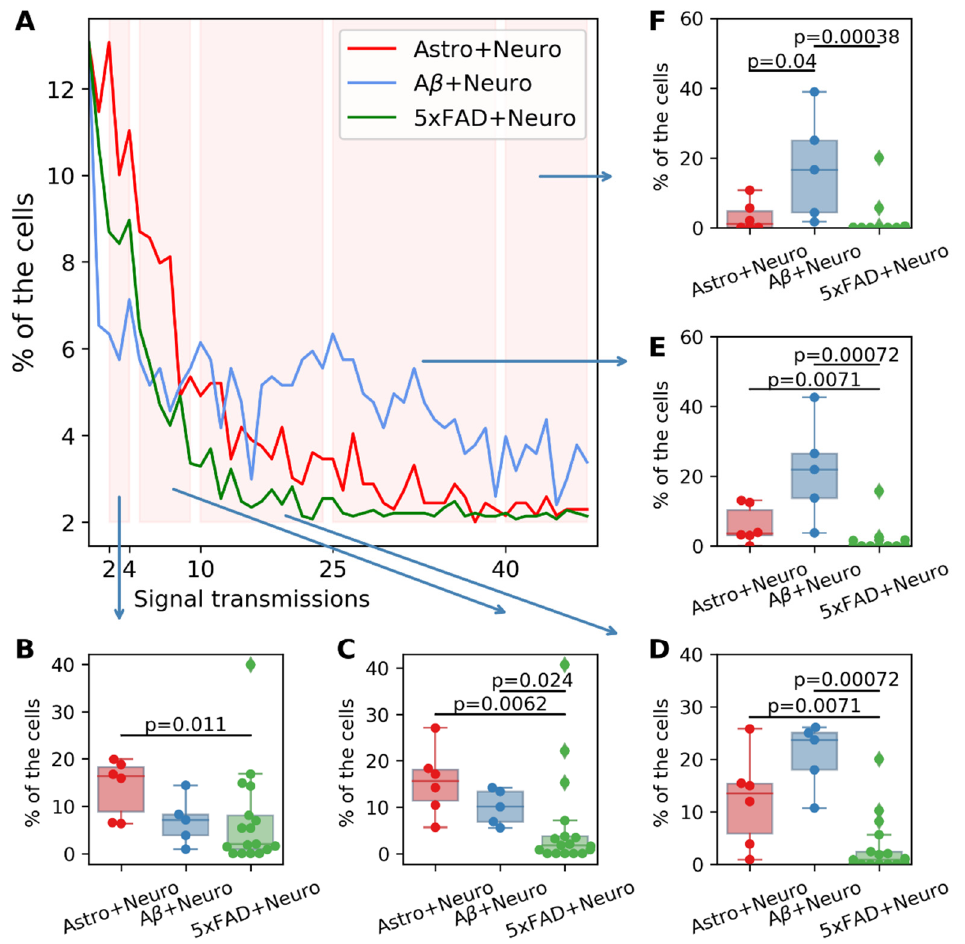
Figure 8. ( A ) Group histograms of cultures of intact astrocytes with replantation of healthy nerve cells (red), astrocytes in pharmacological modeling of AD with replantation of healthy nerve cells (blue), and astrocytes obtained from 5xFAD mice with replantation of healthy nerve cells (green). ( B ) Percentage of cells with 2 to 4 transmissions. ( C ) Percentage of cells with 5 to 10 transmissions. ( D ) Percentage of cells with 11 to 24 transmissions. ( E ) Percentage of cells with 25 to 40 transmissions. ( F ) Percentage of cells with more than 40 transmissions. Significant differences between groups were assessed using Mann–Whitney–Wilcoxon tests.